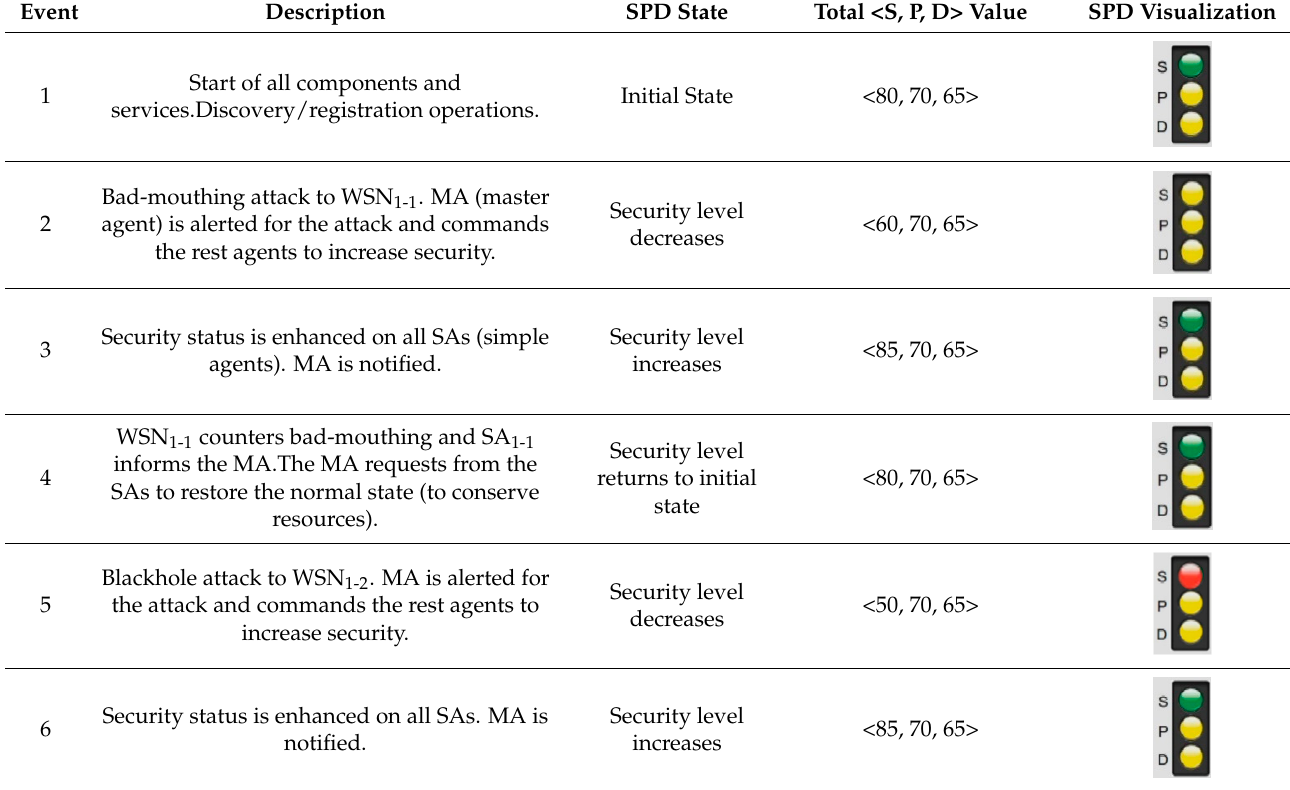
Table 5. Scenario steps of the smart transportation use case.